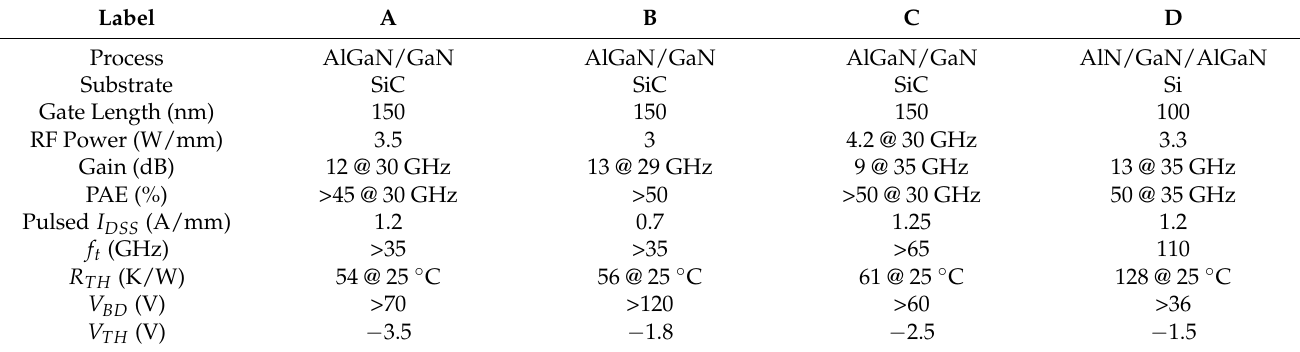
Table 1. Details of the measured Gallium Nitride (GaN) devices. All devices-under-tests (DUTs) have a 4 × 50 µ m periphery.